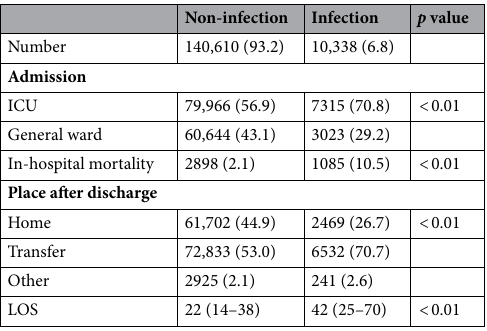
Table 3. Outcome of trauma patients with and without infection. Continuous variables were compared using the Mann–Whitney U test. Categorical variables were compared using the Chi-square test. Missing: place after discharge = 263. ICU intensive care unit, LOS length of hospital stay.